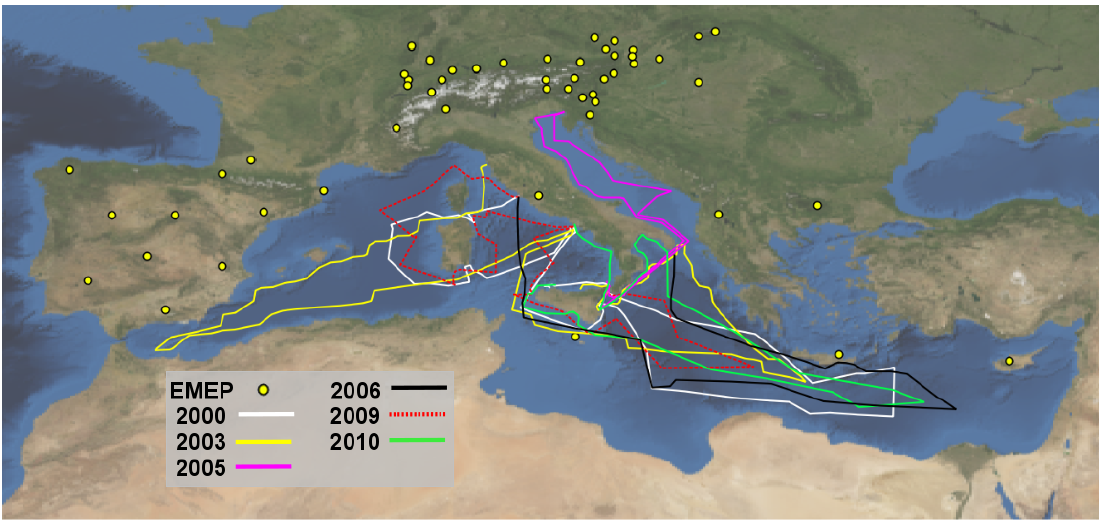
Figure 1. The Med-Oceanor campaign routes over the years and the sites of the European Monitoring and Evaluation Programme (EMEP) stations used in the model